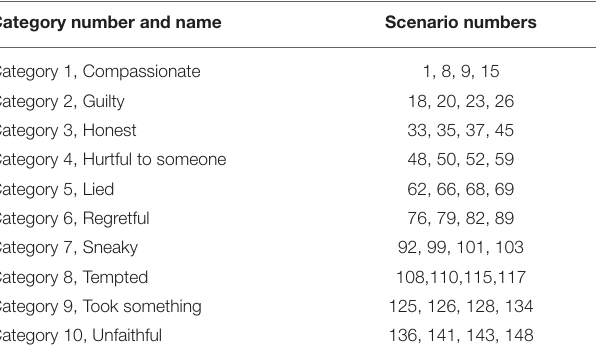
TABLE 3 | The reduced questionnaire based on exploratory factor analysis within each category.